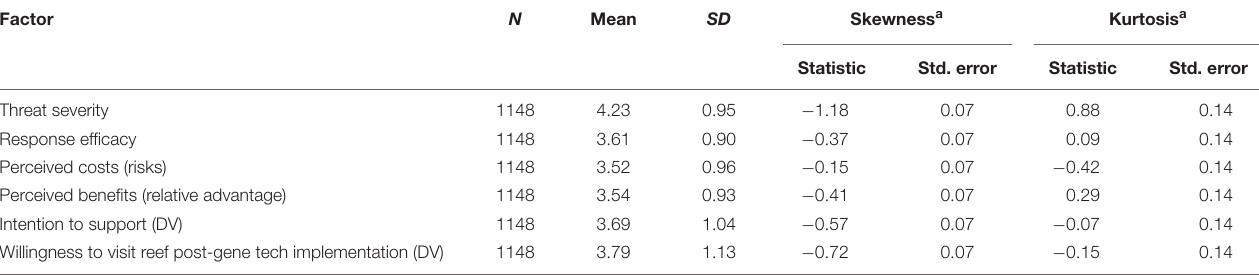
TABLE 1 | Mean scores for independent and dependent variables in the study (excluding implicit threat vulnerability), ranging from 1 – 5, with higher scores reflecting stronger responses. Factor N Mean